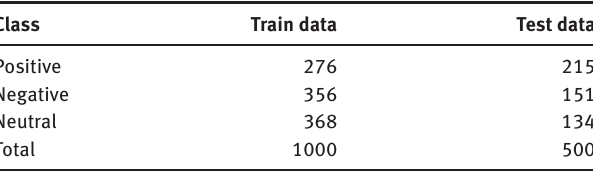
Table 1: Description of the Bengali Sentiment Dataset.